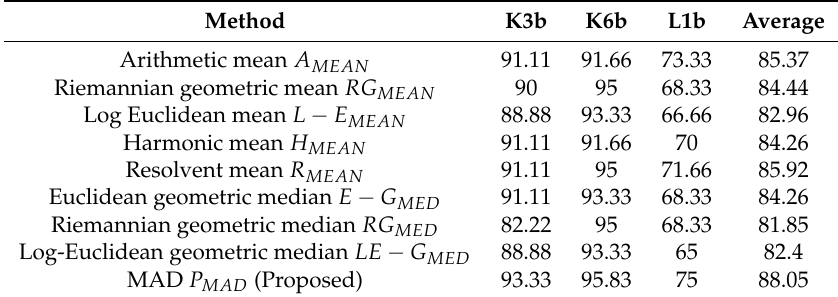
Table 2. The classification accuracy (%) of TSMLDA for BCI III-IIIa.